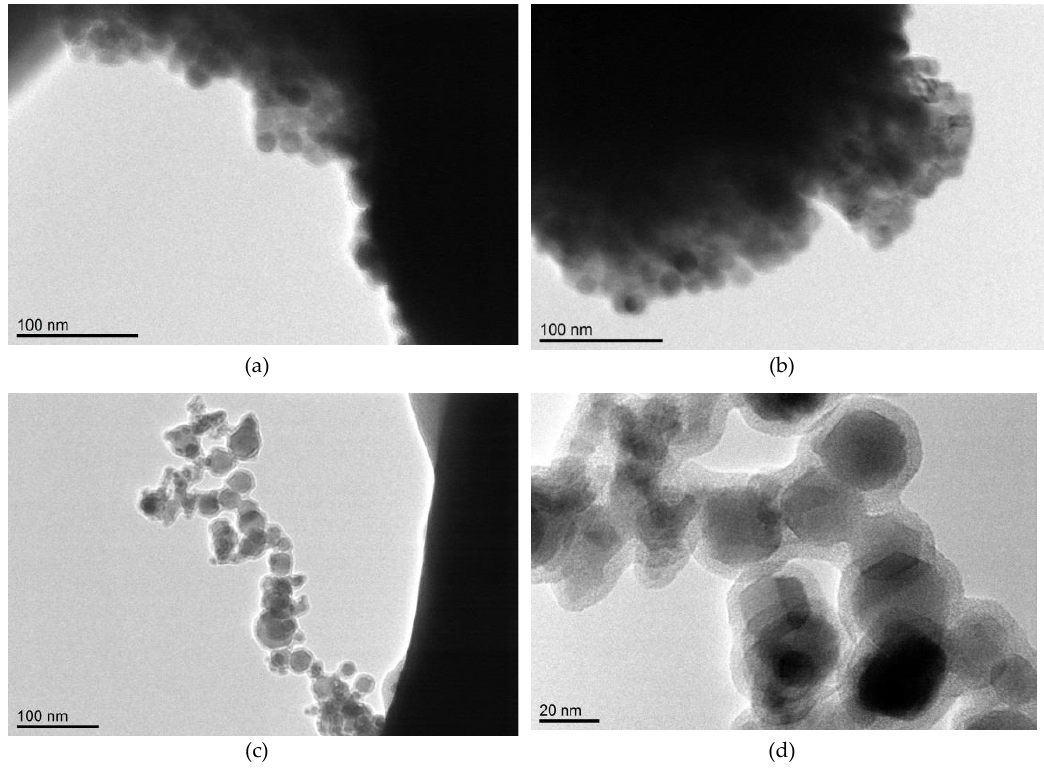
Figure 12. TEM images of ( a ) and ( b ) poly-LM/(1M-POSS 12); ( c ) and ( d ) poly-LM/(1M-POSS 0.5).